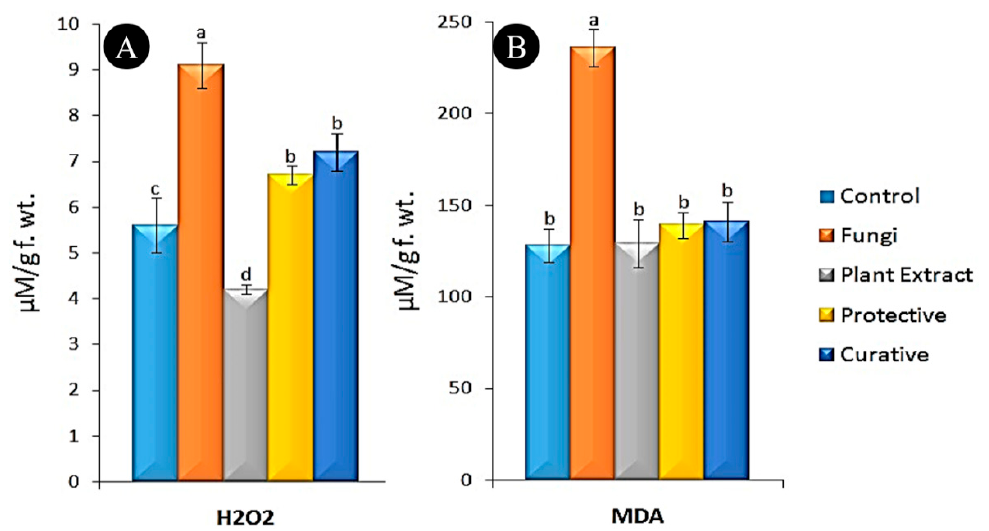
Figure 4. H 2 O 2 activities ( A ) and MDA content ( B ) are expressed in different treatments as µM/g f.wt. The different letters on top of the columns mean the data values were significantly different at p ≤ 0.05.